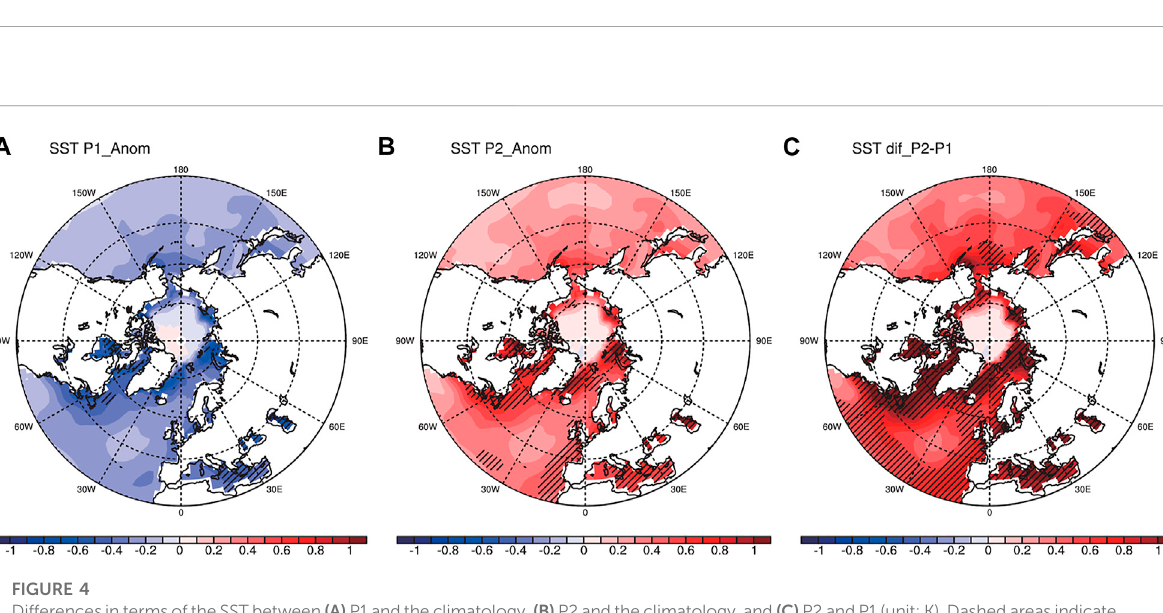
FIGURE 3 Differences in terms of the total cloud cover between (A) P1 and the climatology, (B) P2 and the climatology, and (C) P2 and P1 (unit: %); the second column[ (D – F) ]for the rate ofprecipitation (unit: mm/day); thethird column [ (G – I) ]for thedownwardsolar radiation fl ux atsurface(unit: W/ m 2 ). Dashed areas indicate signi fi cance at 95% con fi dence level according to the Student ’ s t -test.